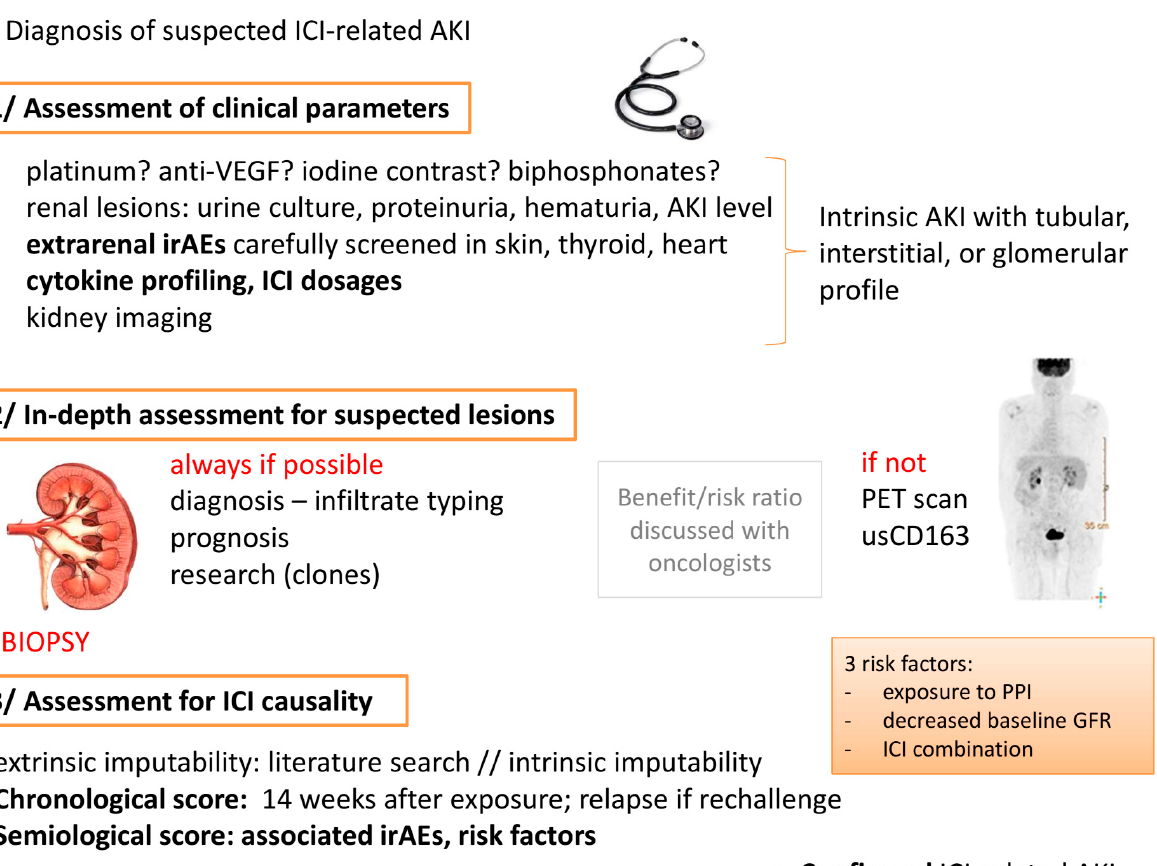
Figure 2. Diagnostic strategy for AKI in a patient exposed to ICIs. When a patient presents with AKI, the clinician should assess whether it is ICI-related. This diagnosis can be difficult, which is why a careful strategy helps to elucidate the causal relationship between the patient’s clinical and biological signs and the exposure to ICIs. PET scan: Positron emission tomography; usCD163: dosage of soluble CD163 level in urine.